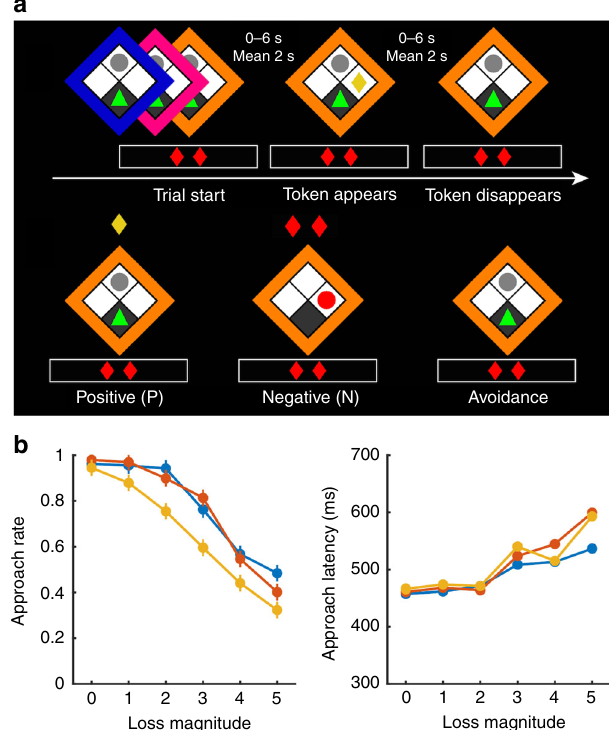
Fig. 1 Approach/avoidance con fl ict task. a Top: Loss probability (indicated by the frame colour) and magnitude (number of red diamonds) are shown at trial start, while reward magnitude is always one token. The player (green triangle) is located at the safe position at the bottom corner of the grid and an inactive predator (grey circle) is located at the top corner. After a random time interval, a token appears either on the left or the right side, and disappears after another random time interval. Bottom: If the player leaves the safe position to approach the token, one of three outcomes ensues: a positive outcome P, if the player collects the token and safely returns to the initial position; a negative outcome N, if the predator wakes up and catches the player, causing the loss of a number of tokens; or a rare neutral outcome (not shown), in which the token disappears before the player can reach it. Alternatively, the player can decide to not perform an action and avoid the token. The trial ends 1000 ms after the disappearance of the token. b Behavioural results. Approach rate (left) and average approach latency (right) for each loss probability and magnitude; error bars represent the standard error of the mean (s.e.m.). See Table 1 for inference